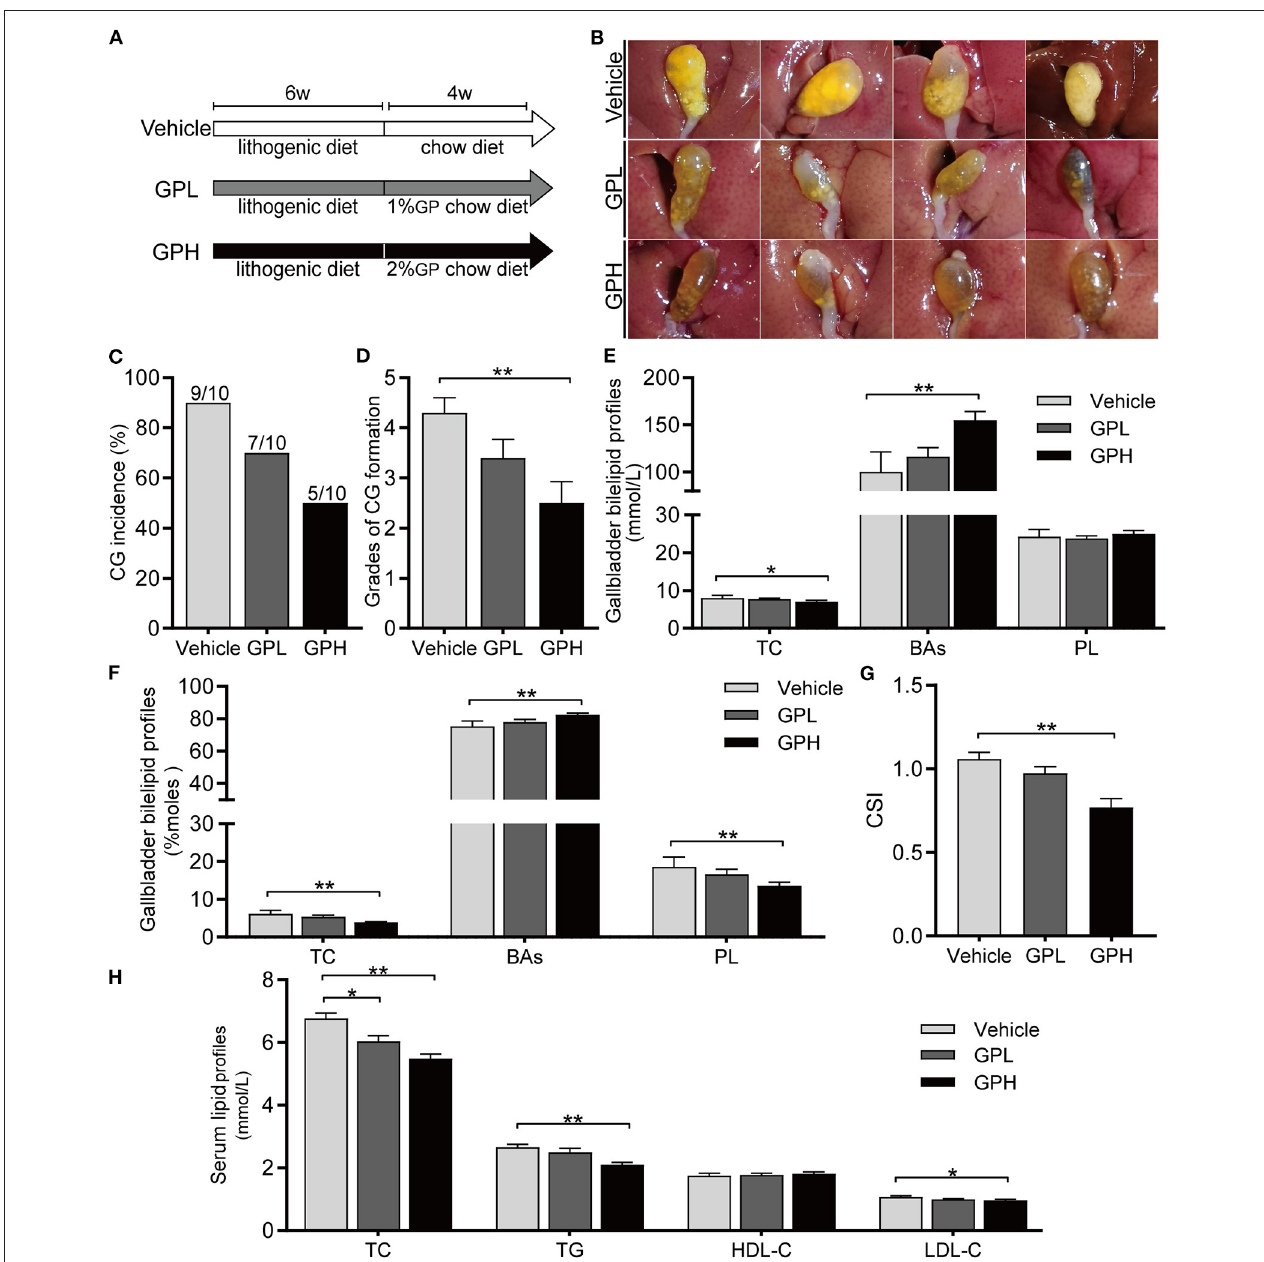
FIGURE 8 | Effect of GPs on the dissolution of preexisting cholesterol gallstones (CGs). (A) Study design showing diets and durations of GPs treatments. (B) Representative gallbladders per group. (C) CG incidence. (D) Grades of CG formation. (E) Bile concentrations of total cholesterol (TC), bile acids (BAs) and phospholipids (PL). (F) Molar percentages of TC, BAs and PL. (G) Cholesterol Saturation Index (CSI). (H) Serum concentrations of TC, triglycerides (TG), low-density lipoprotein-cholesterol (LDL-C) and high-density lipoprotein-cholesterol (HDL-C). Data are reported as means ± SEM ( n = 10). * P < 0.05, ** P <